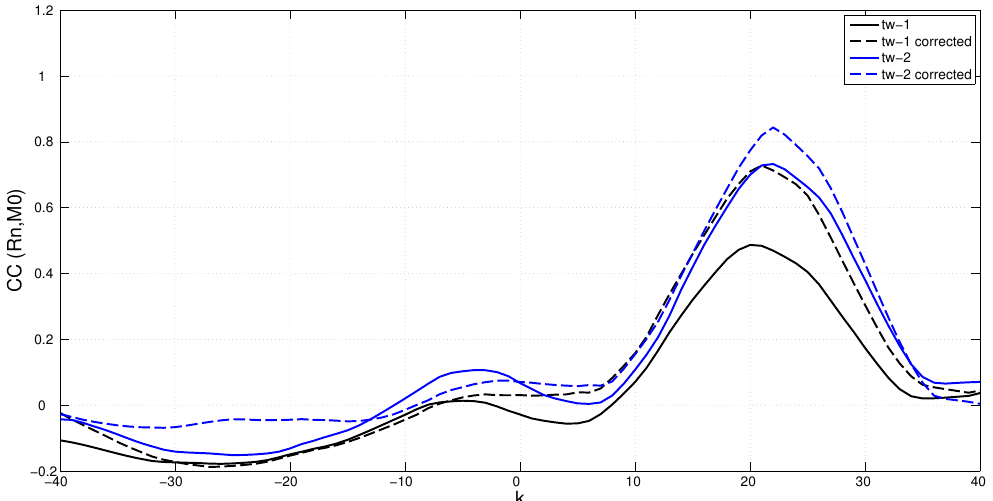
Figure 7. Cross-correlation function (CC) between radon concentration Rn and seismic moment release M 0 time series, filtered with a 14-days moving average and evaluated in two different time windows (black line for tw-1 and blue line for tw-2), with (dashed lines) and without (solid lines) correction coefficients. Both the values of correction coefficients and time windows bounds are summarized in Table